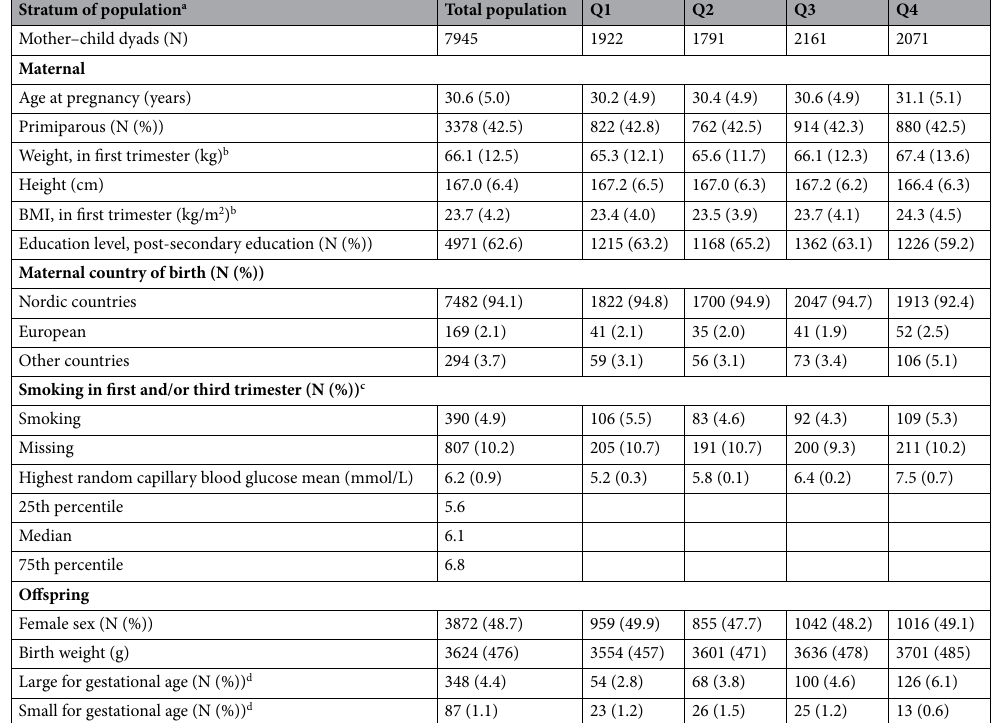
Table 1. Characteristics of population. N numbers of observations. Data represent the mean (SD), unless otherwise indicated. a Total population and population divided by quartiles of highest maternal random